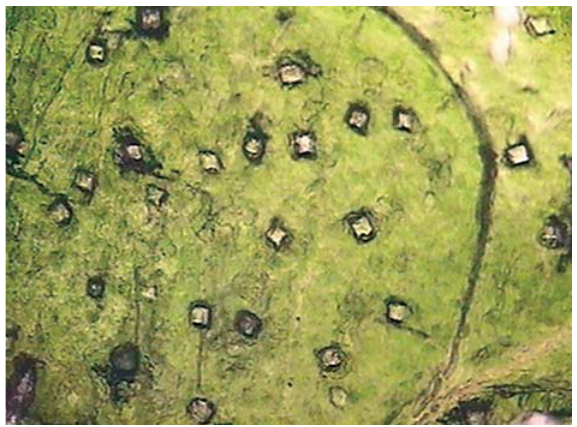
Figure 1 – CaOx crystals observed in Phyllanthus niruri leaves observed under light